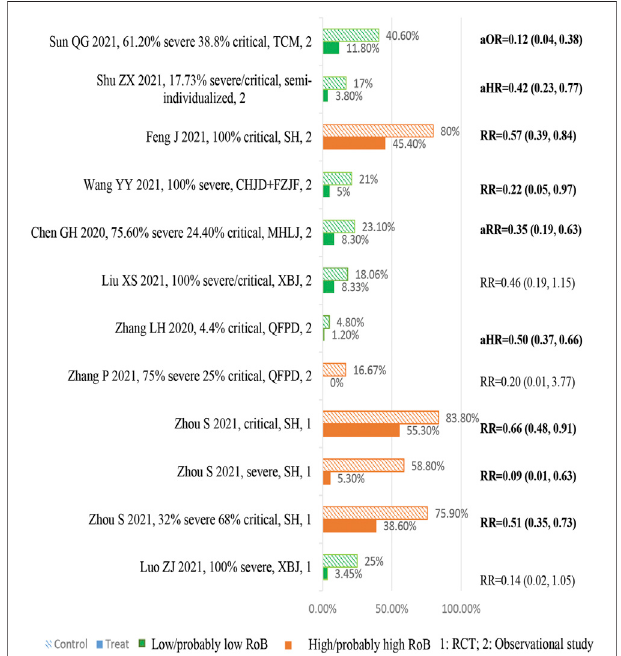
FIGURE 4 | Summary chart of